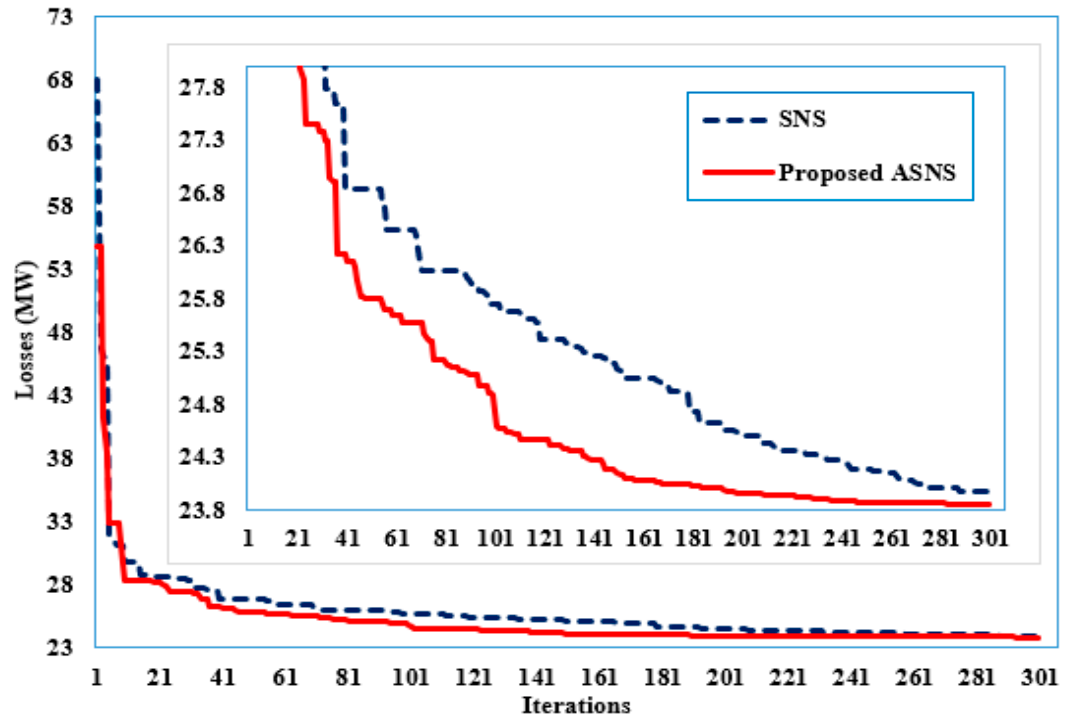
Figure 8. Convergence features of the proposed ASNS and SNS for Case 1 of the IEEE 57-bus grid.